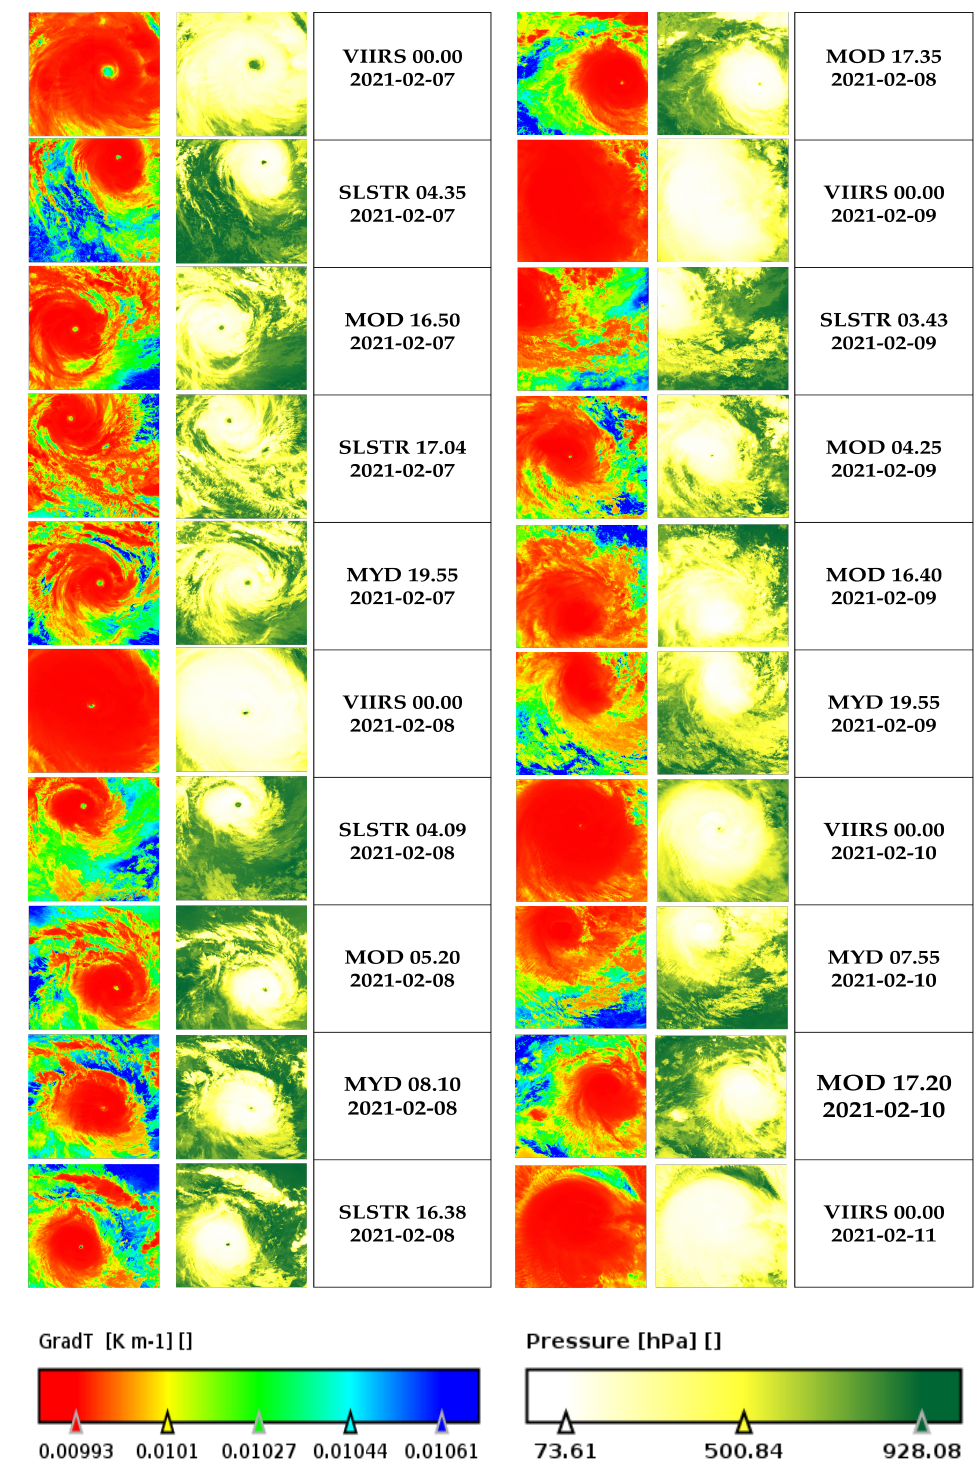
Figure 14. Temporally ordered sequences of the Faraji’s evolution of |∇ T | (first and fourth columns, from top to bottom) and P (second and fifth columns, from top to bottom) are shown, with the images between 00.00 UTC of 7 February 2021 and 00.00 UTC of 11 February 2021. Color bars identify the range scales of |∇ T | and P , with values averaged over all sensing